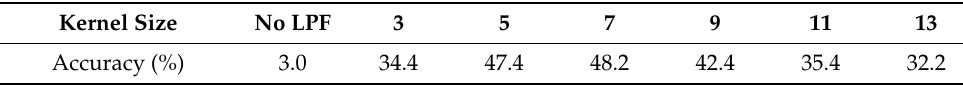
Table 3. Accuracy when applying an LPF to adversarial example of (cid:101) = 8. Kernel Size